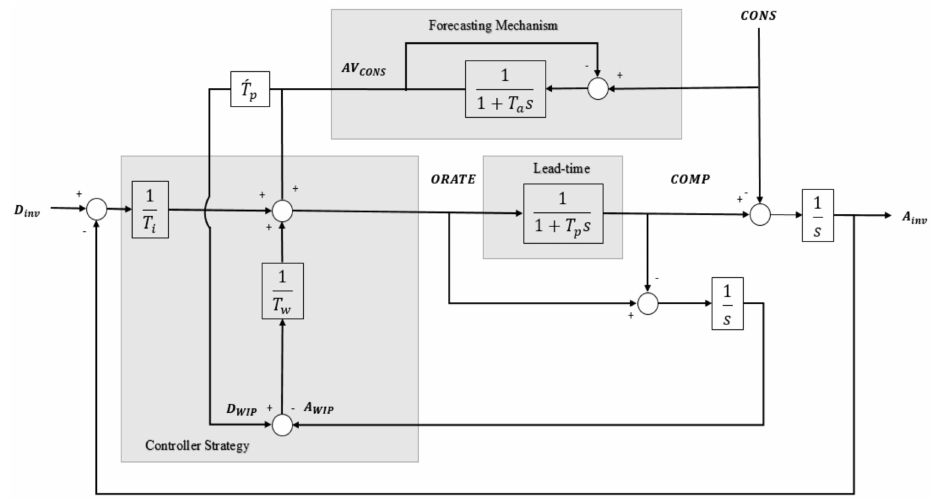
Figure 1. Block diagram of the automatic pipeline, inventory, and order based production control system (APIOBPCS)